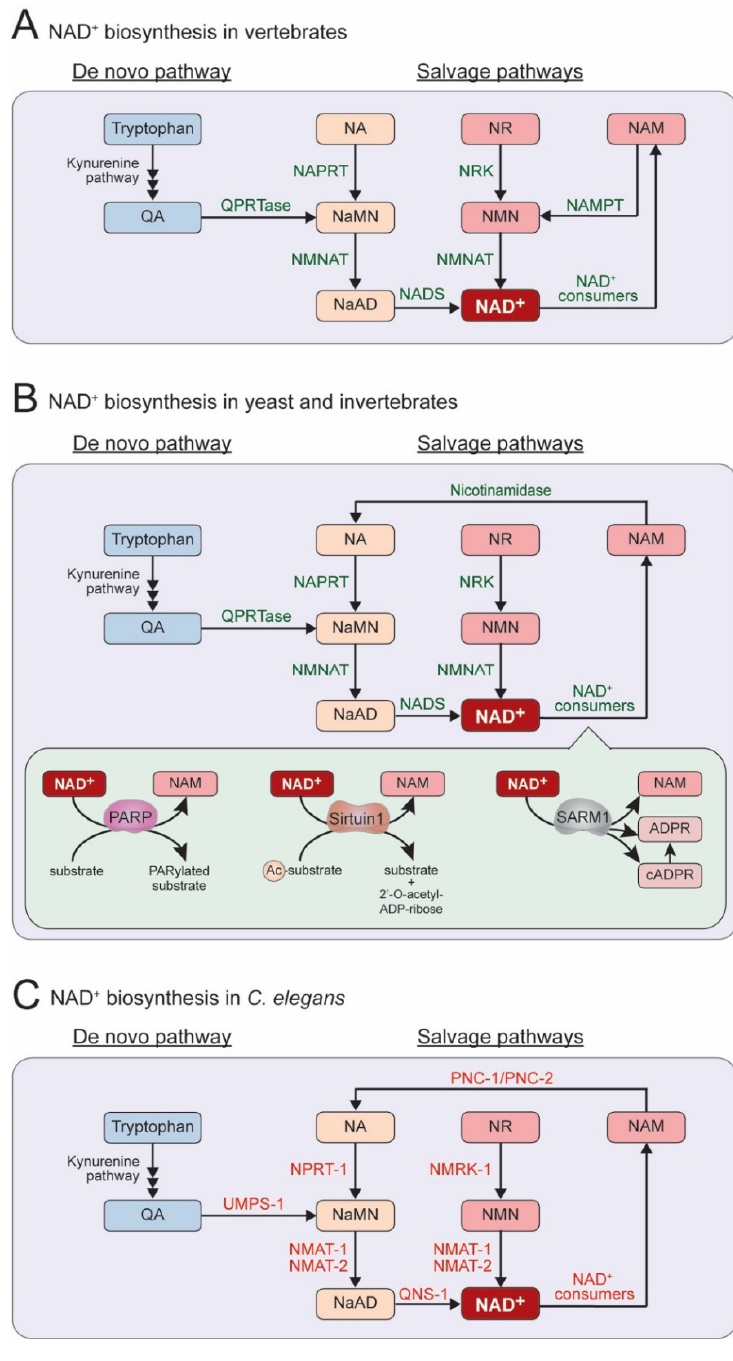
Figure 2. NAD + biosynthesis pathway in ( A ) vertebrates, ( B ) yeast and invertebrates, and ( C ) C. elegans . PARylated, Poly Adenosine diphosphate (ADP)-Ribosylated; ADPR, ADP-ribose; cADPR, cyclic ADPR.